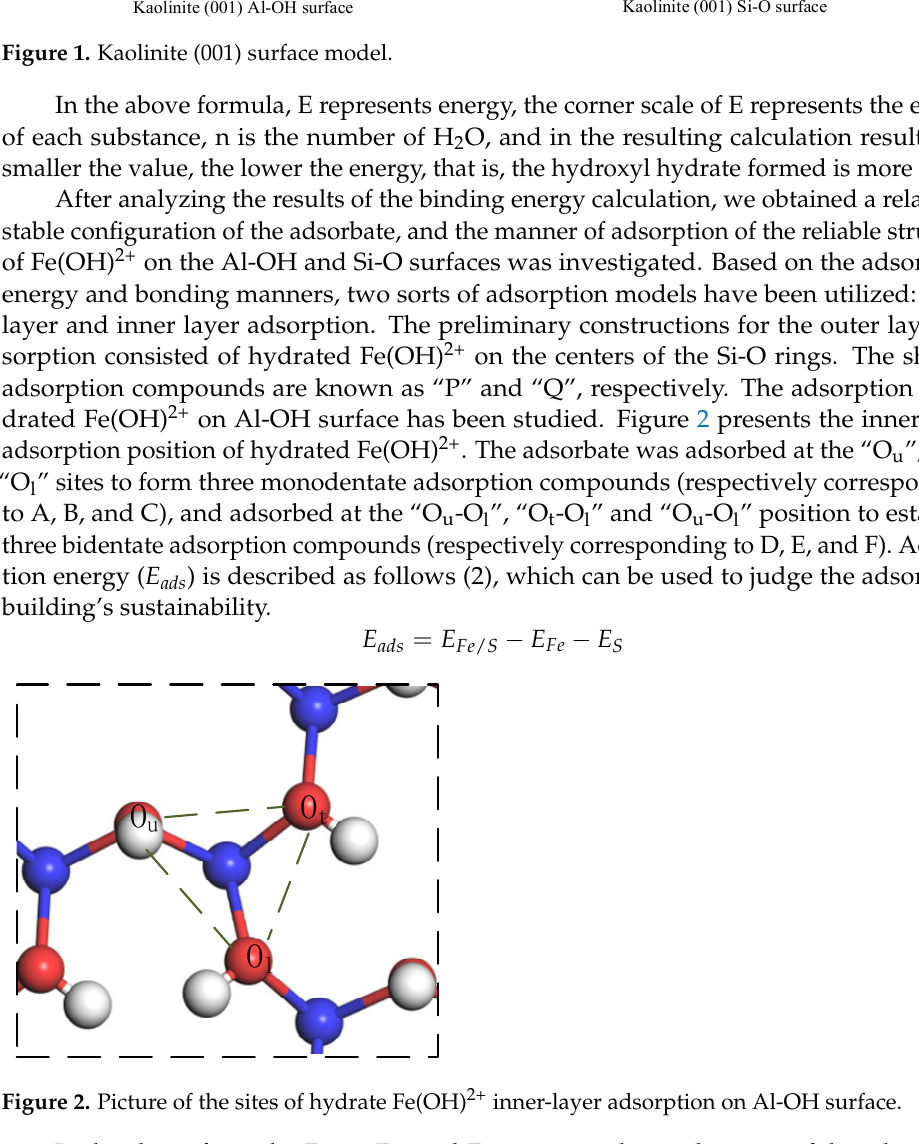
Figure 1. Kaolinite (001) surface model.